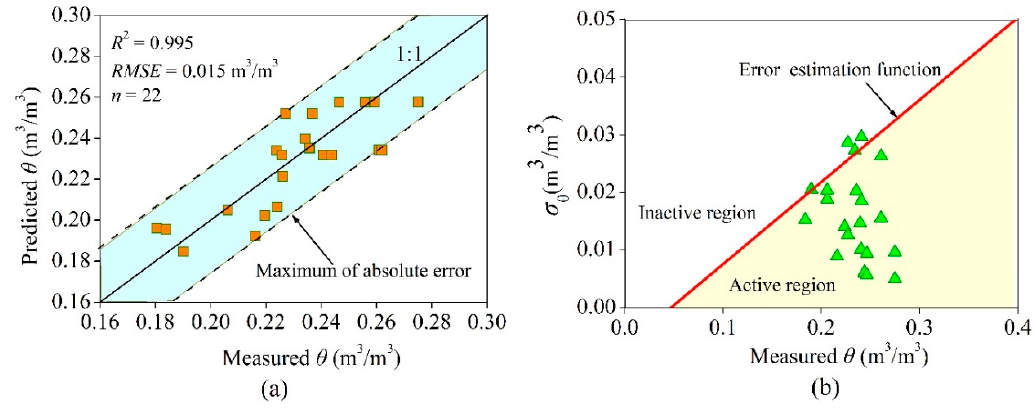
Figure 12. Error analysis of the ATPS: ( a ) absolute error analysis, and ( b ) error estimation function assess.